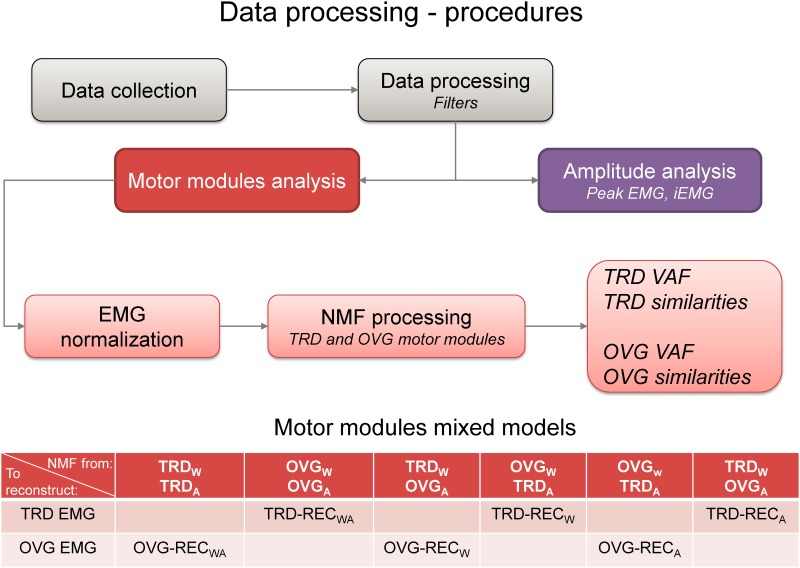
Schematic representation of EMG data processing.EMG data from treadmill (TRD) and overground running (OVG) were band-pass filtered, low-pass filtered and segmented into (20) running cycles. These segmented data were processed for the extraction of peak EMG and integrated EMG. In addition, the filtered and segmented data were processed using non-negative matrix factorization (NMF) in order to extract muscle weightings and respective activation signals for TRD and OVG separately. We reconstructed the original EMG from OVG (OVG EMG) by mixing muscle weightings and activation signals from TRD condition, generating a reconstructed OVG-RECWA. A second mixed model was the reconstruction of the original EMG from OVG by mixing TRD muscle weightings and OVG activation signals, generating a reconstructed OVG-RECW. The third mixed model was the reconstruction of the original EMG from OVG by mixing OVG muscle weightings and TRD activation signals, generating a reconstructed OVG-RECA. This same procedures were applied for the reconstruction of the original EMG from TRD.